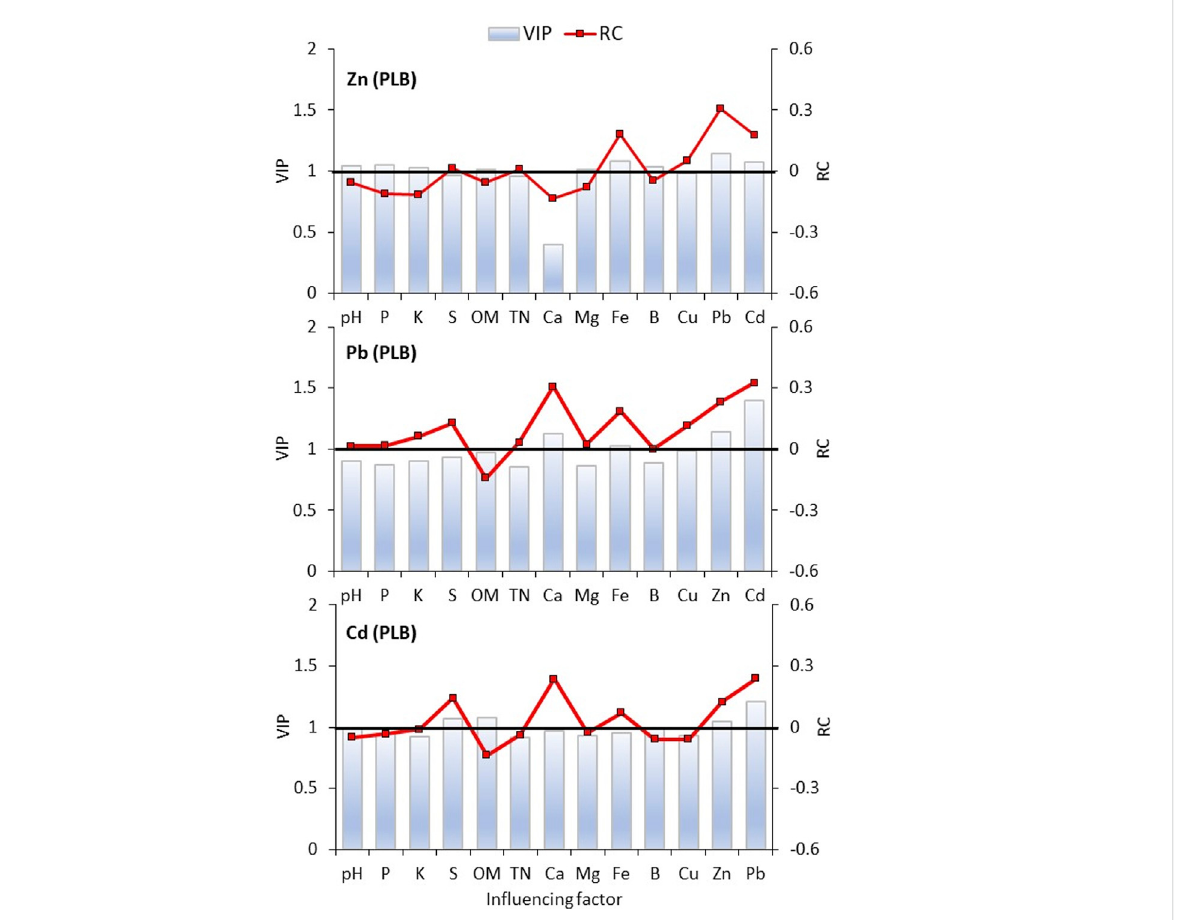
FIGURE 6 PartialLeastSquareRegressionmodel(PLSR)offactorsin fl uencingthecontentofheavy metalsinasoilamendedwithpoultrylitter-derivedbiochar (PLB). VIP is Variable Importance in Projection. When VIP > 1, it means that the independent variable is important for predicting the dependent variable; whereas it is less important at VIP < 0.5. The regression coef fi cients (RC) indicate the action direction of each independent variable. Results comprise the whole dataset of